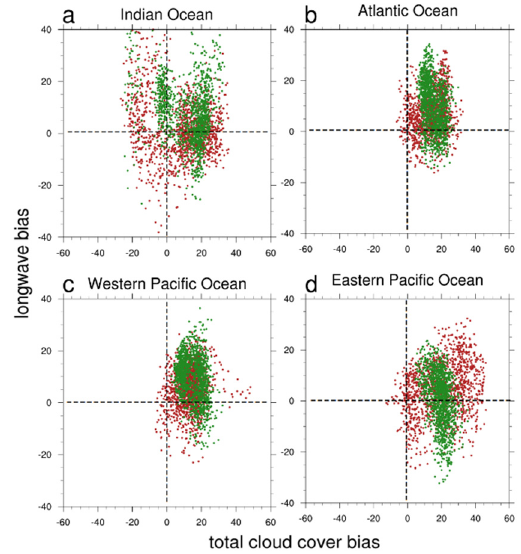
Figure 10. Relationship between bias in the total cloud cover (%) and bias in Q LW (W m − 2 ) over the ( a ) Indian (40 ◦ E–100 ◦ E), ( b ) Atlantic (70 ◦ W–10 ◦ E), ( c ) western Pacific (100 ◦ E–160 ◦ E), and ( d ) eastern Pacific Oceans (120 ◦ –70 ◦ W) during December-January-February (DJF, red) and June-July-August (JJA, green).